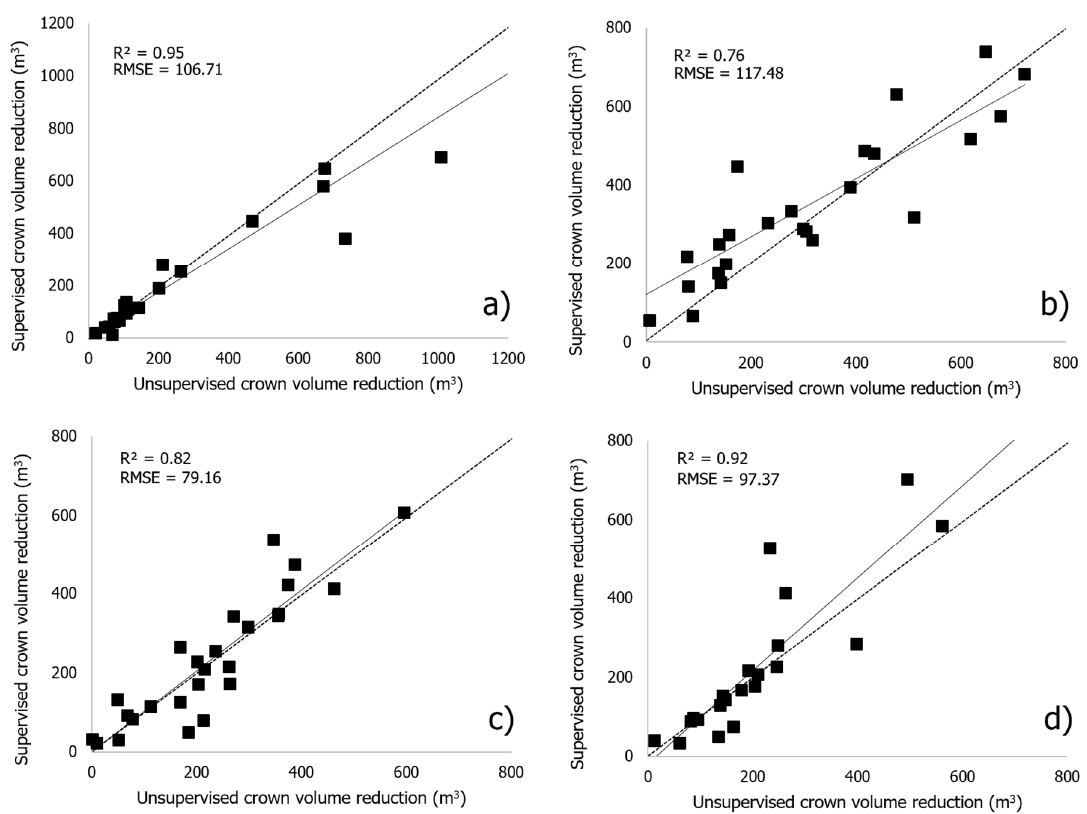
Figure 5. Comparison between crown projected volume reduction extracted by means of the supervised and unsupervised approach within each site ( a , b , c , d ). The dataset was made of both correctly segmented crown (matched) and fragmented crown (split) as a sum of each sub-polygon of the fractionated crown described in Table 4.